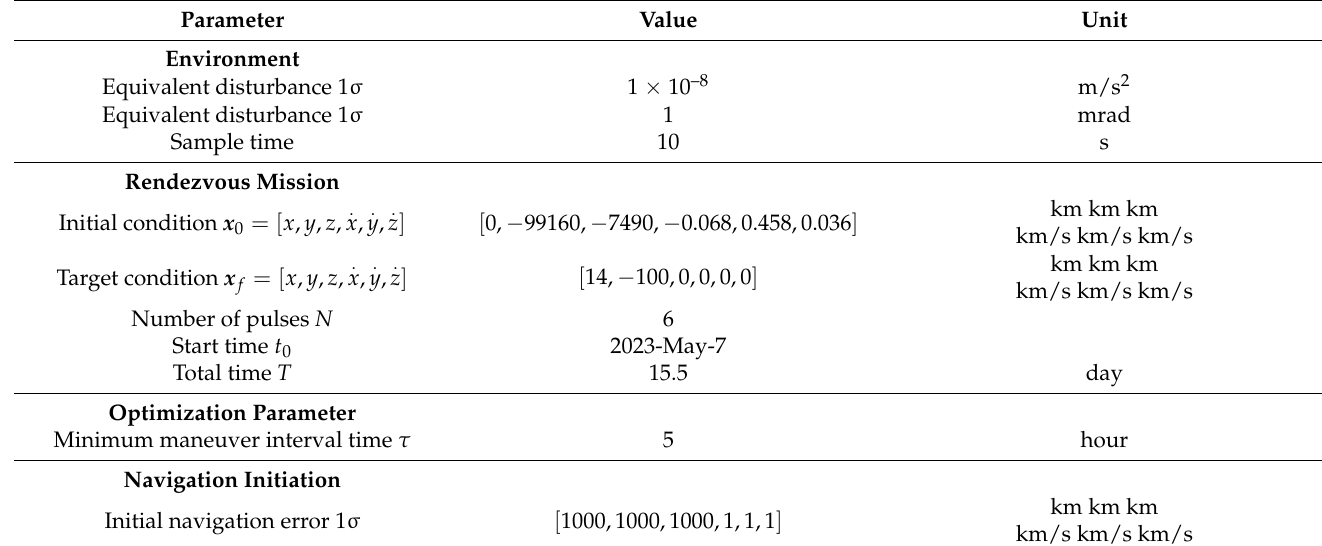
Table 2. Simulation